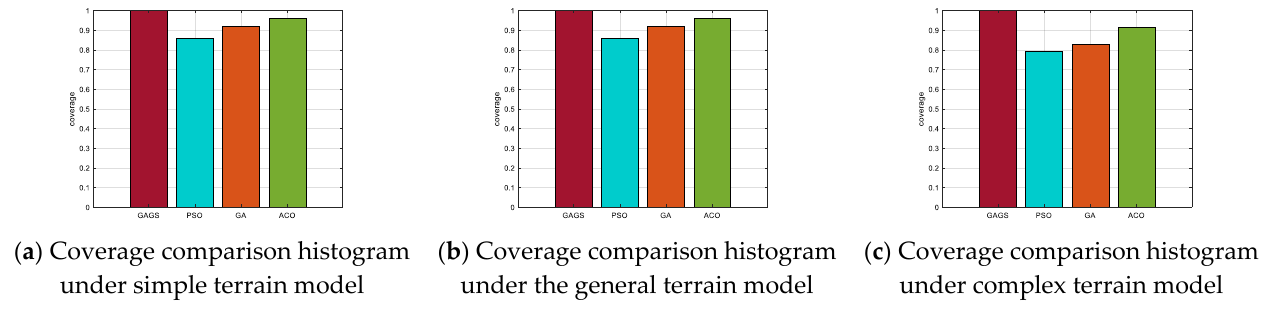
Figure 10. Coverage comparison histogram.